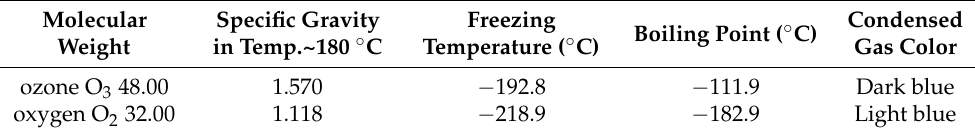
Table 1. Comparison of some ozone and oxygen physical properties [48,53].